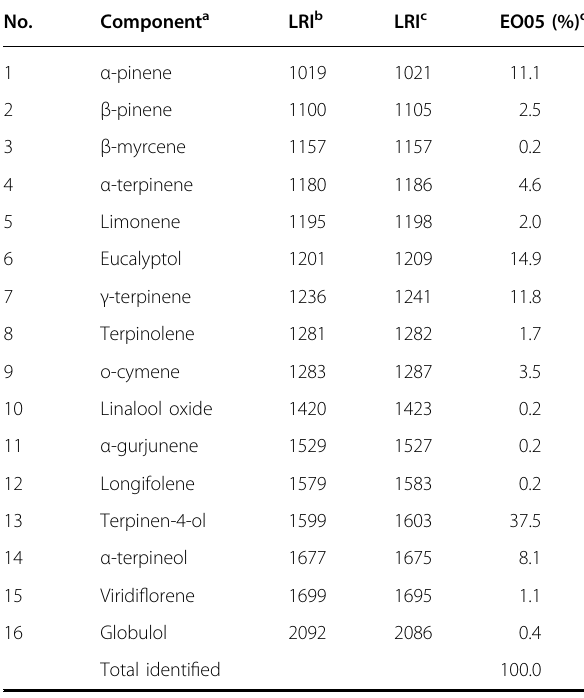
The chemical composition of EO05 was identi fi ed by GC-MS analysis. a The components are reported according to their elution order on polar column. b Linear Retention indices (LRI) measured on polar column. c LRI from